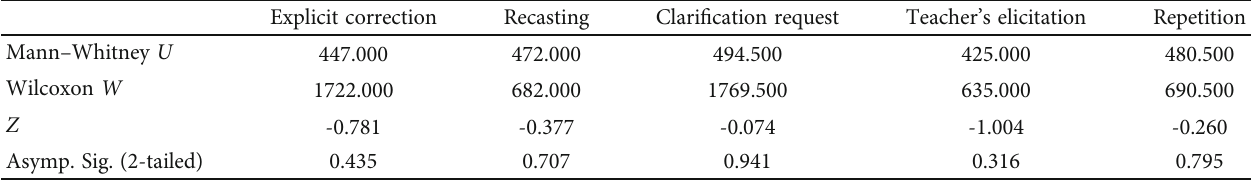
Table 5: Mann – Whitney U test statistics of di ff erence between teachers ’ and students ’